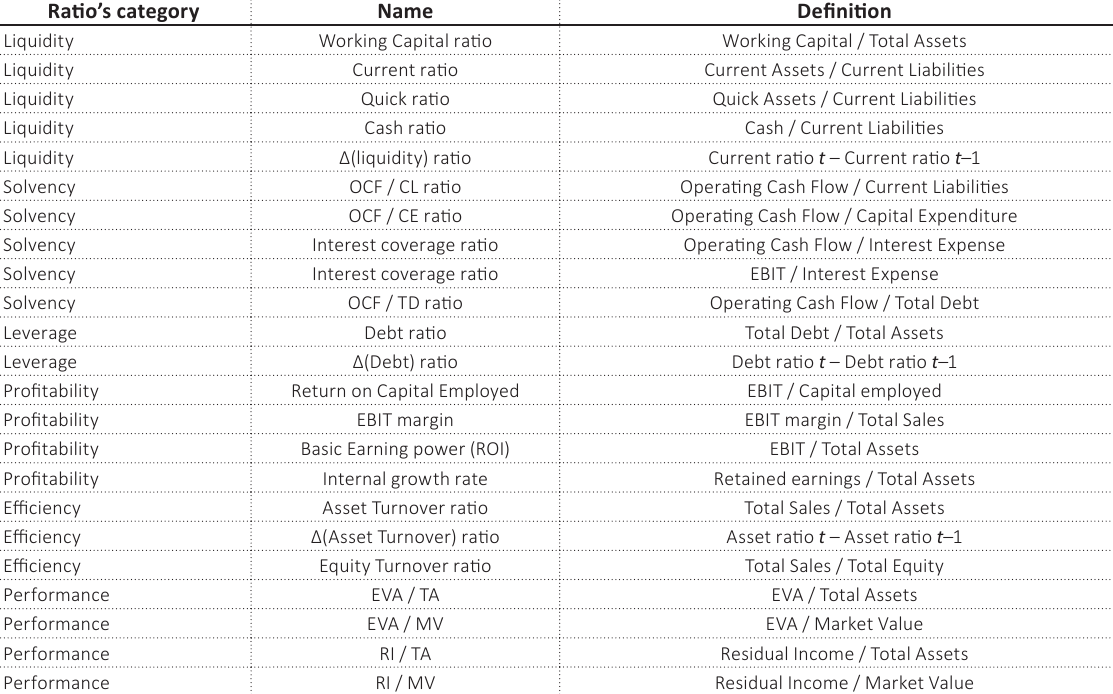
Table 1. Initial list of potential predictor